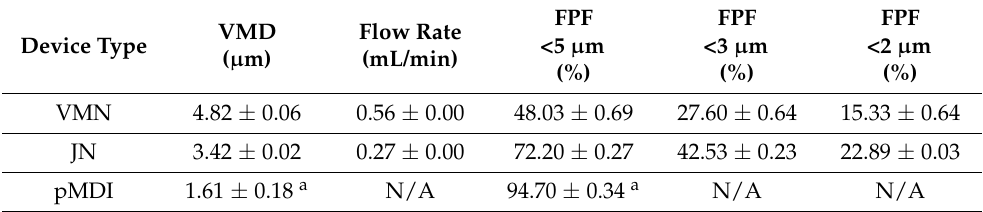
Table 1. Droplet size characterisation of aerosol delivery devices.